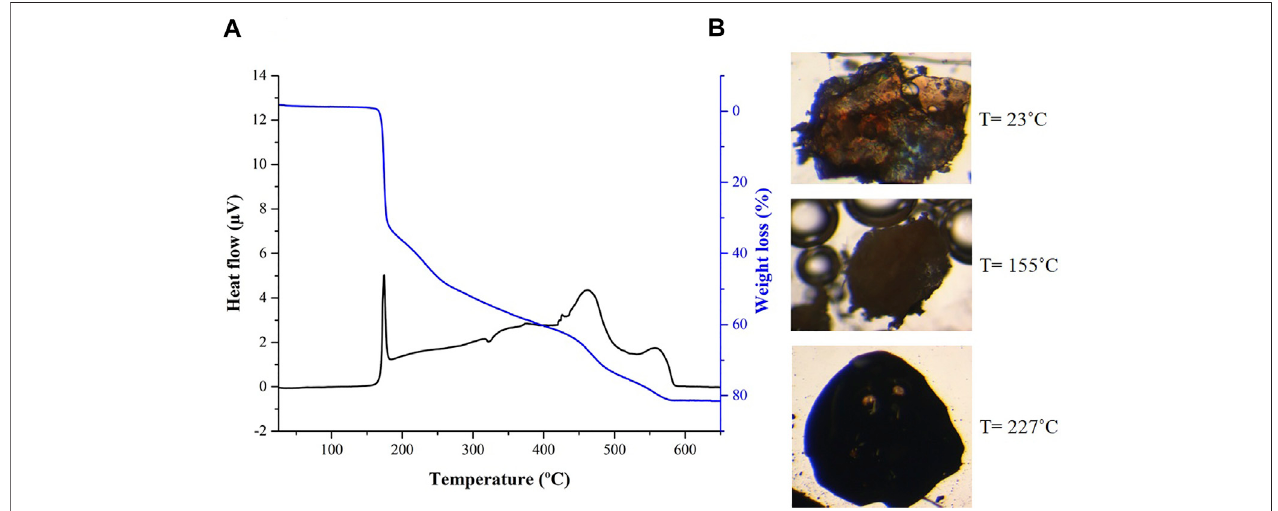
FIGURE 9 | (A) Differential scanning calorimetry (DSC) and thermogravimetry (TGA) and (B) hot-stage microscopy (HSM) images at 23, 155 and 227 ° C for compound [Ag(I)-Tazo 2 ].